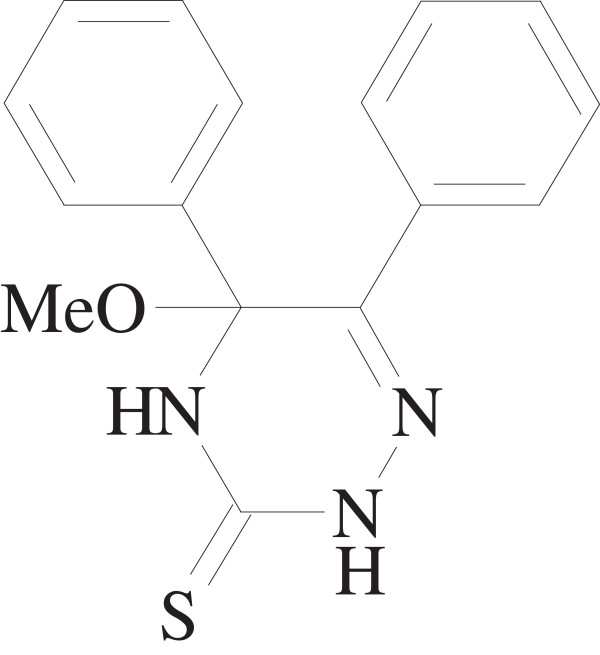
Chemical structure of 5-Methoxy-5,6-diphenyl-4,5-dihydro-2H-1,2,4-triazine-3-thione.